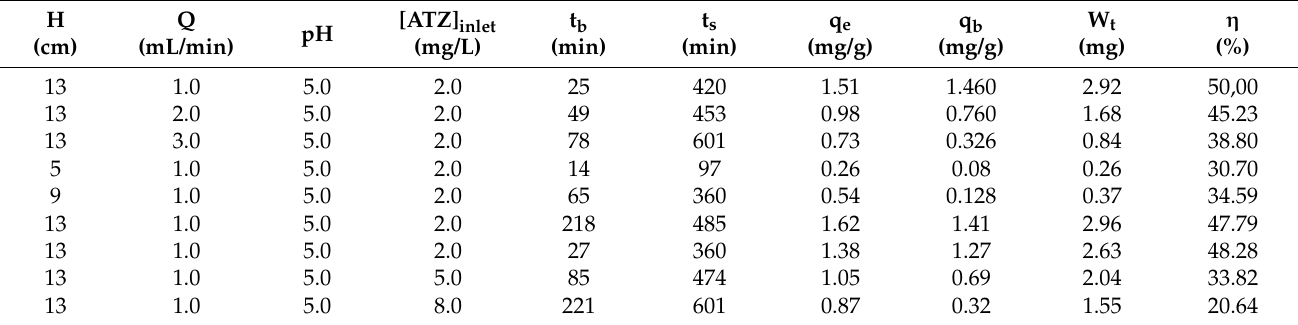
Table 2. Parameters of the breakthrough curves for the ATZ adsorption in a packed-bed column using Moringa oleifera Lam. seeds as